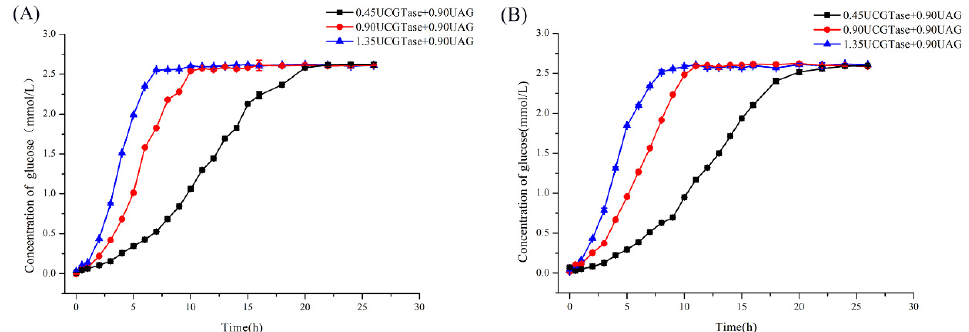
Figure 5. Release time of ( A ) vanillin- β -CD and ( B ) curcumin- β -CD using different amounts of β -CGTase and AG.